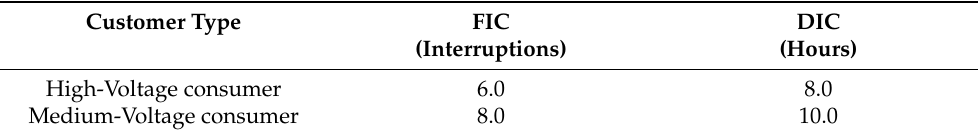
Table 9. Continuity limits for individual indicators in